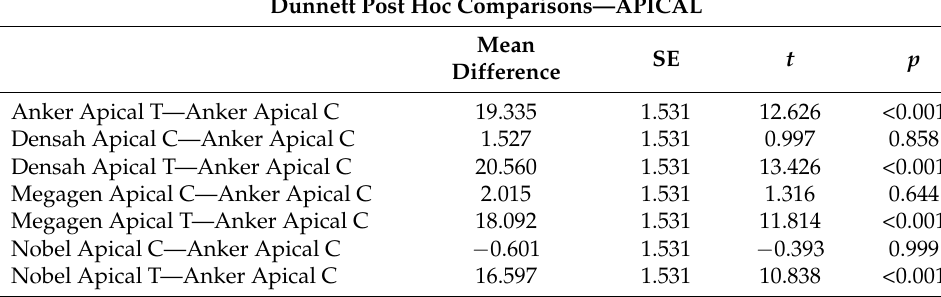
Table 7. Statistical comparison of the relative bone condensation at the apical region for all groups. The test groups (counterclockwise drilling) showed increased relative bone condensation compared to the controls (clockwise drilling). T =Test, C = Control, SE = Standard Error, t = test, p = p value. Dunnett Post Hoc Comparisons—APICAL Mean